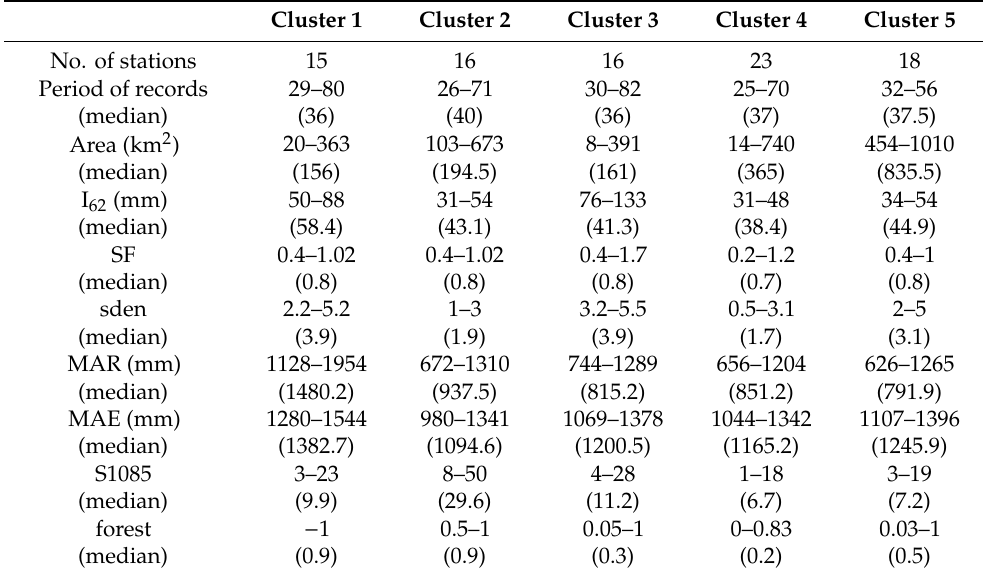
Table 7. Detail of the clusters formed by Ward’s hierarchical clustering method.